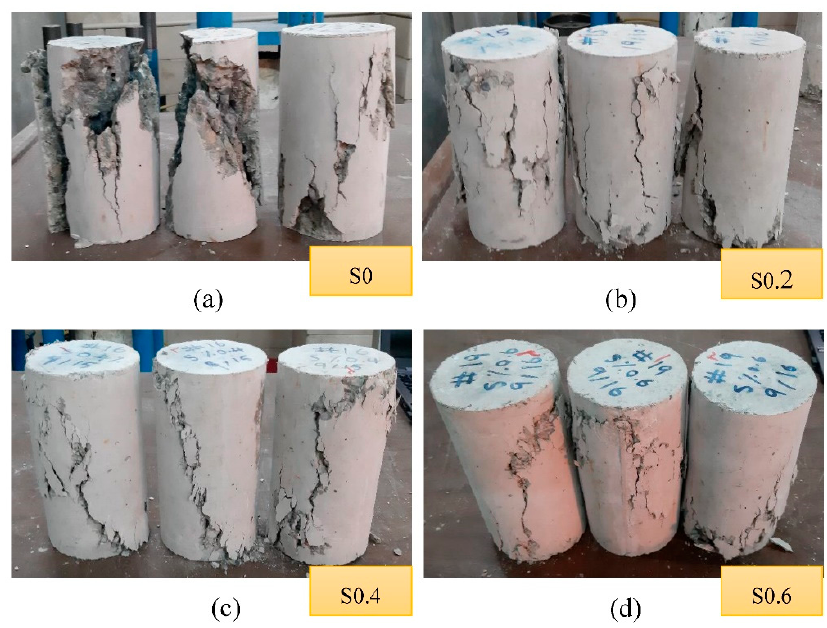
Figure 6. Failure patterns observed in compressive strength test ( a ) S0 ( b ) S0.2 ( c ) S0.4 ( d ) S0.6.